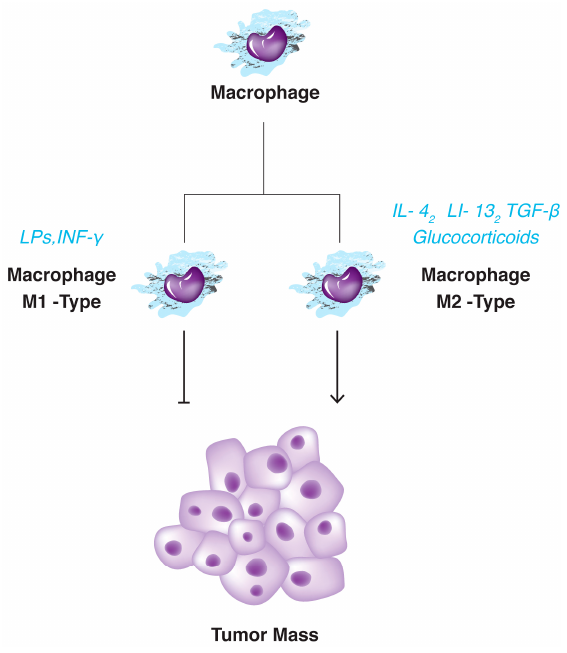
Figure 4. Tumor associated macrophages (TAMs) are different from conventional macrophages which act againts tumor formation.